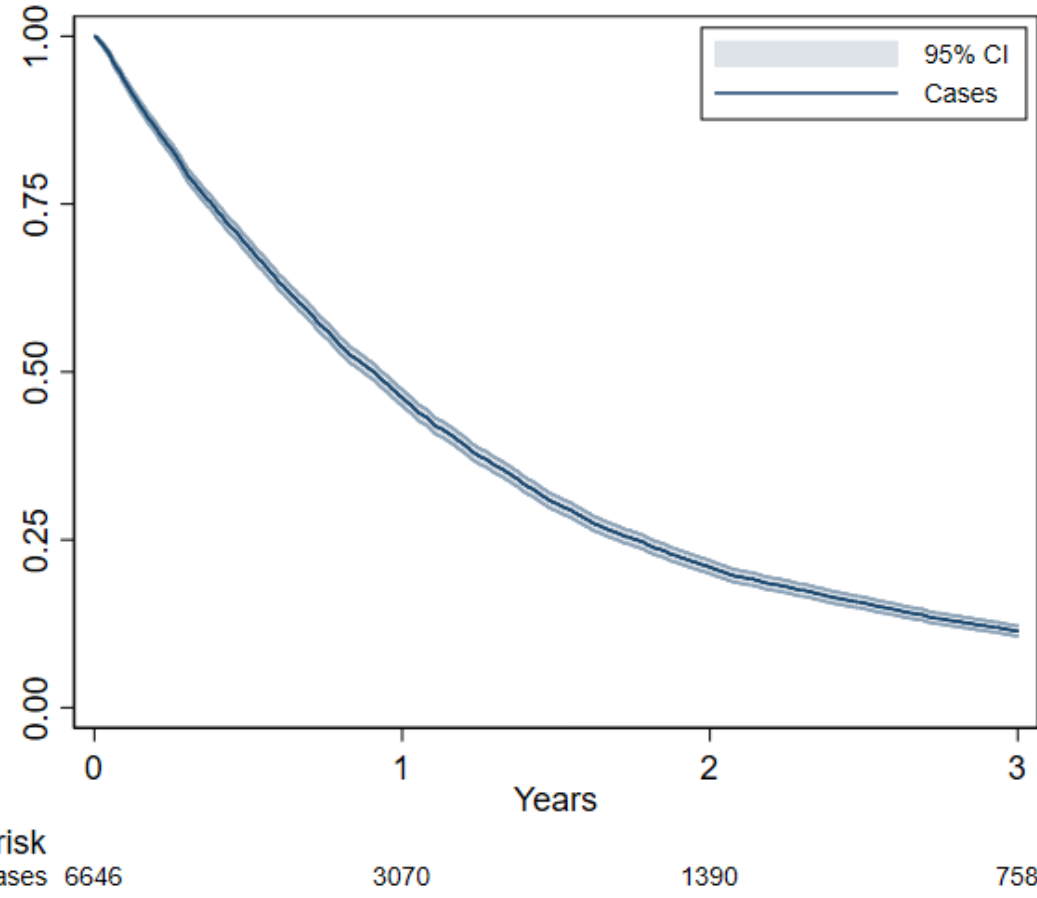
Figure 1. Overall survival estimated using Kaplan–Meier curve, Lombardy, 2000–2018. Follow-up period 2000–2021. Table 4. Prognostic factor analysis in the entire study population, Lombardy 2000–2018. Follow-up period